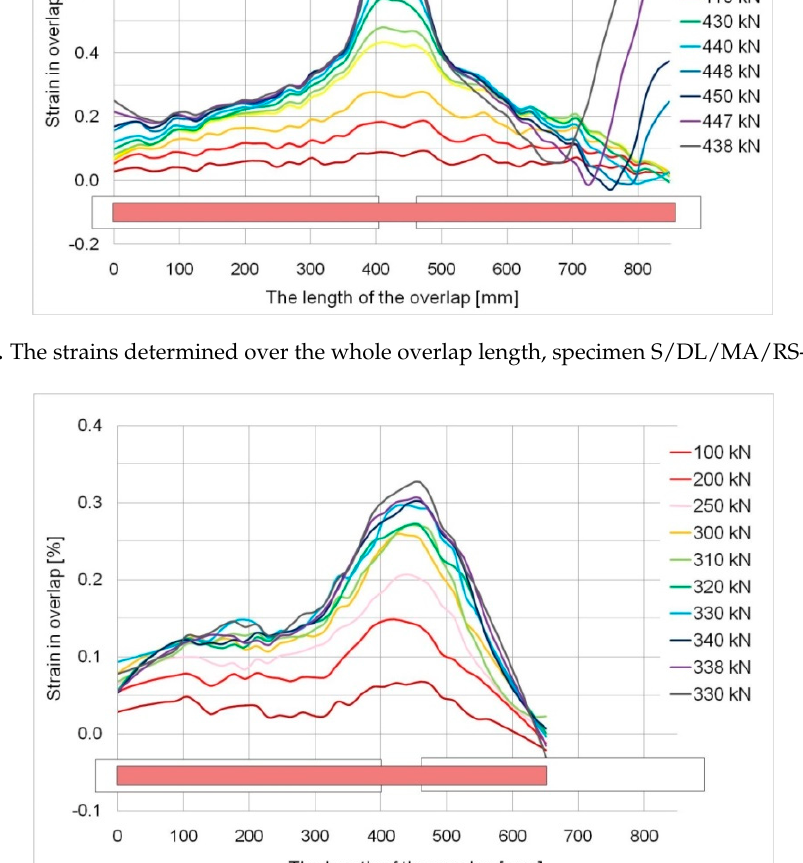
Figure 15. Specimen S/DL/MA/RS-400-4/P2: ( a ) Strain measured in the basic plate, ( b ) calculated slip between the overlap and basic plate.